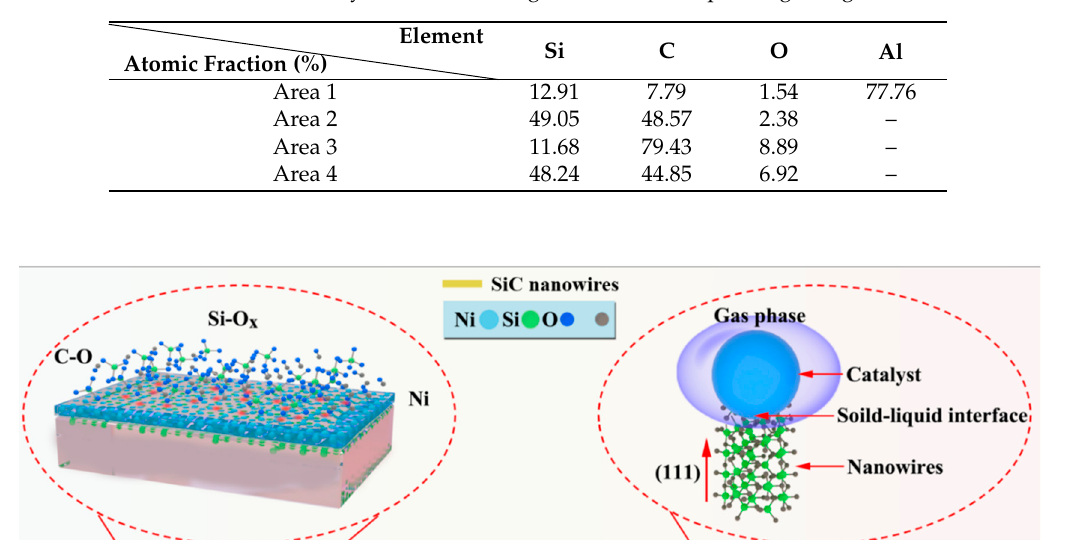
Table 3. Elemental analysis of different regions in N3 corresponding to Figure 6a,b.